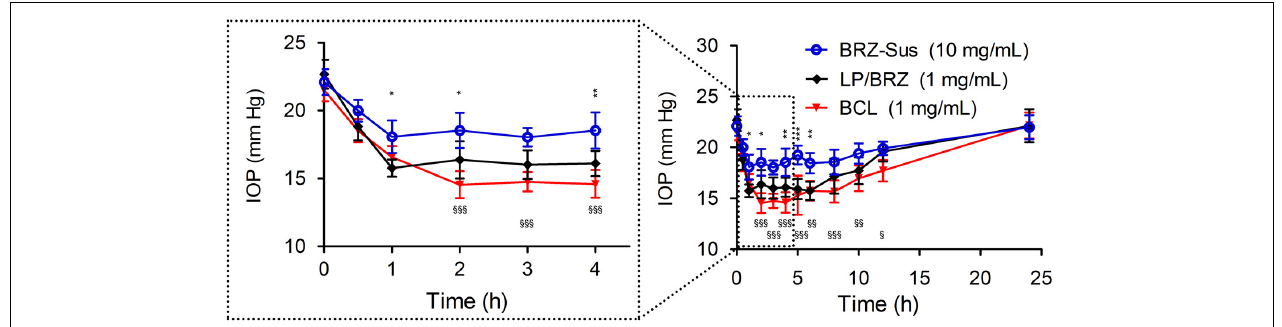
FIGURE 7 | In vivo intraocular pressure (IOP) profiles of white New Zealand rabbits treated with BRZ-Sus, LP/BRZ, and BCL. Data are expressed as mean ± SD ( n = 6) ( ∗ p < 0.05, ∗∗ p < 0.01, and ∗∗∗ p < 0.001 vs. LP/BRZ; § p < 0.05, §§ p < 0.01, and §§§ p < 0.001 vs. BCL).